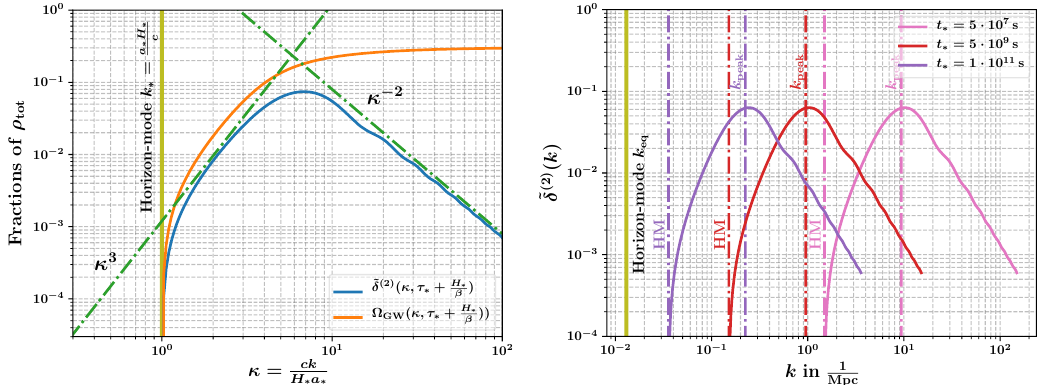
Figure 6: Left: In blue the numerical solution of Eq. (84) at the end of the phase transition and with initial conditions ˜ δ ( 2 ) ( κ , t ) = ˜ δ ( 2 ) (cid:48) ( κ , t ) = 0 and for α → ∞ and β/ H ∗ = 1. We also show the source term in orange at the end of the phase = τ + H /β . Right: Induced density perturbation by GWs from FPT. transition τ ∗ ∗ ev For demonstration purposes we chose α → ∞ , β = H ∗ . Shown are solutions for different scales a ∗ H ∗ in comparison with the horizon at matter-radiation